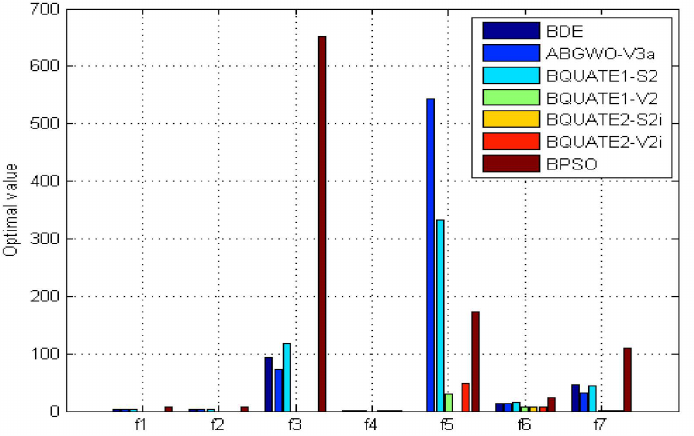
Figure 6. The optimal values of BDE, ABGWO-V3a, BQUATE1-S2, BQUATE1-V2, BQUATE2-S2i, BQUATE2-V2i, and BPSO on f1-f7.